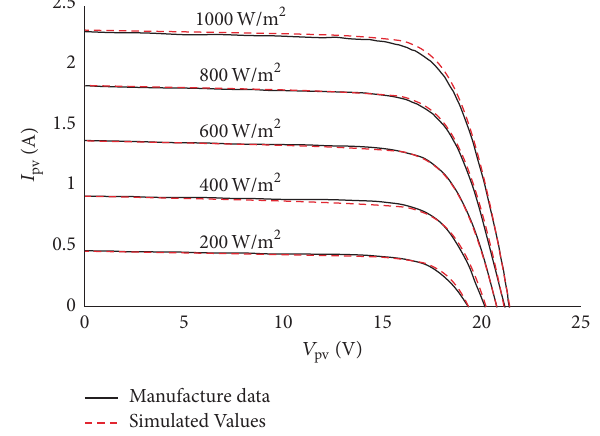
Figure 7: 𝐼 pv - 𝑉 pv characteristic curves at different irradiation levels for Shell